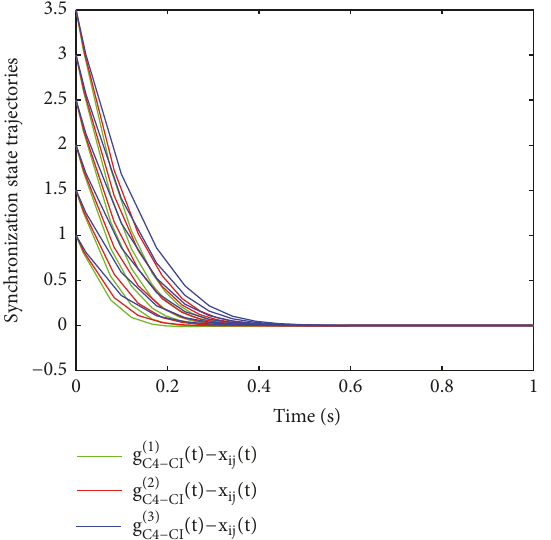
Figure 7: Synchronization state trajectories of the network (36) for the case II of Corollary 21.